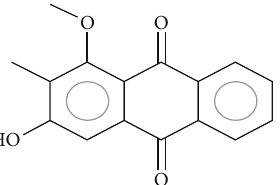
Figure 1: Chemical structure of the studied compound Rubiadin-1- methyl